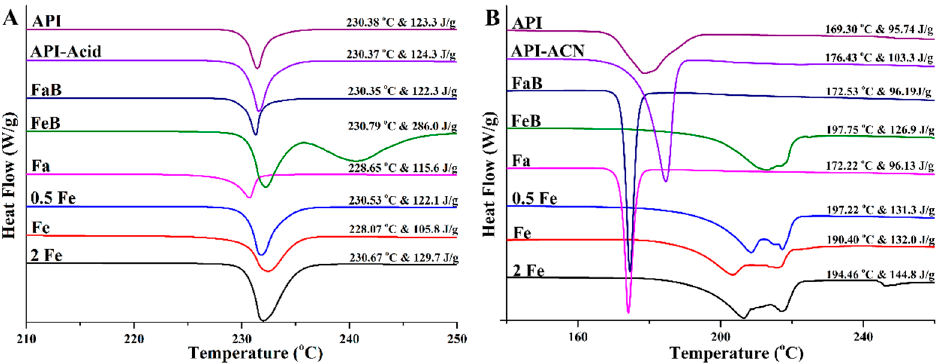
Figure 4. DSC thermogram of different precipitates. ( A ): Rivaroxaban; ( B ): Drug-A. (API-Acid/API-ACN, FaB, FeB, Fa, 0.5 Fe, Fe, and 2 Fe indicate that precipitate comes from the medium of organic solvent, FaSSIF buffer, FeSSIF buffer, FaSSIF, 0.5 × FeSSIF, FeSSIF, and 2 × FeSSIF, respectively).